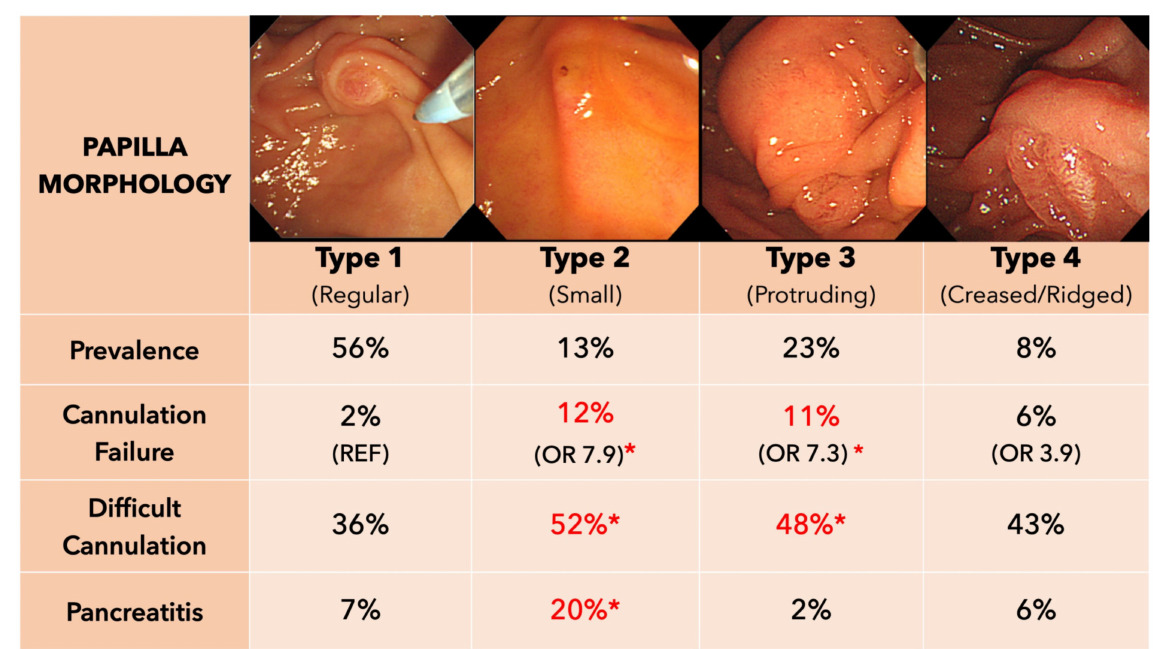
Figure 1. A proposed classification of the papilla morphology and the associated difficulty during bile duct cannulation. * Significantly higher risk vs. Type 1